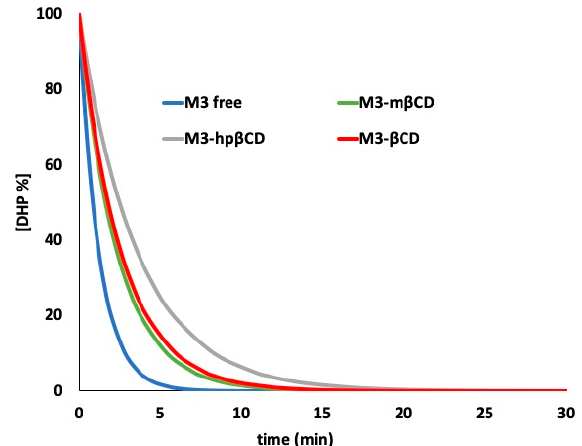
Figure 4. Photodegradation of M3 in the cyclodextrin complexes.